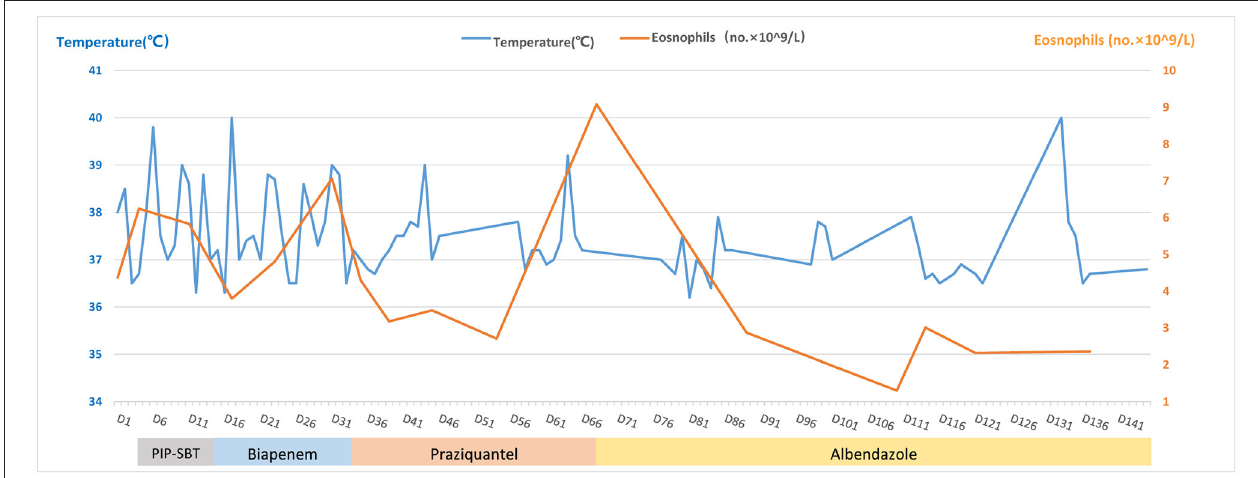
FIGURE 2 | Timeline with relevant data from the episode of care; curves of body temperature and eosinophils count. The blue line shows the body temperature values. The orange line shows the eosinophil counts. Horizontal thick lines show the medications administered. PIP-SBT,